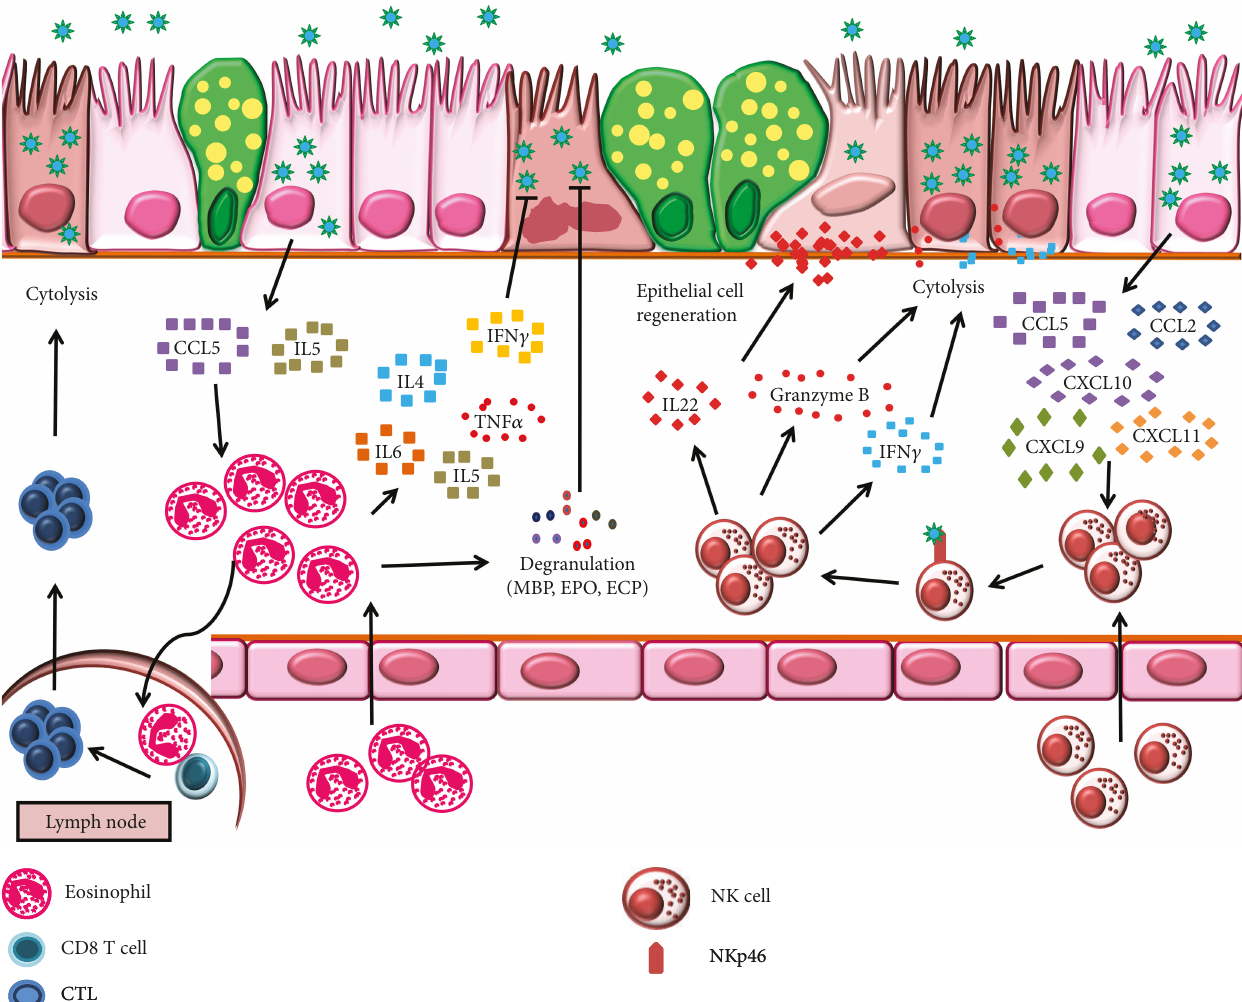
Figure 3: Immunoprotection and immunopathology mediated by eosinophils and natural killer (NK) cells during in fl uenza. CCL5 and IL-5 released by IAV-infected airway epithelium mediate eosinophil tra ffi cking into the lungs. Eosinophils undergo piecemeal degranulation and secrete in fl ammatory cytokines that exert anti-IAV activity. Additionally, IAV-infected eosinophils migrate to draining lymph nodes to present viral antigen to CD8 + T cells. Once activated, cytotoxic T cells tra ffi c to the lungs to lyse IAV-infected cells. NK cell recruitment is driven by CCL2, CCL5, CXCL9, CXCL10, and CXCL11 secreted by IAV-infected airway epithelium. Engagement of IAV with NK cell receptor NKp46 activates NK cell e ff ector functions. Perforins, granzyme B, and IFN γ released by NK cell destroy IAV-infected cells while IL-22 aids in the regeneration of damaged